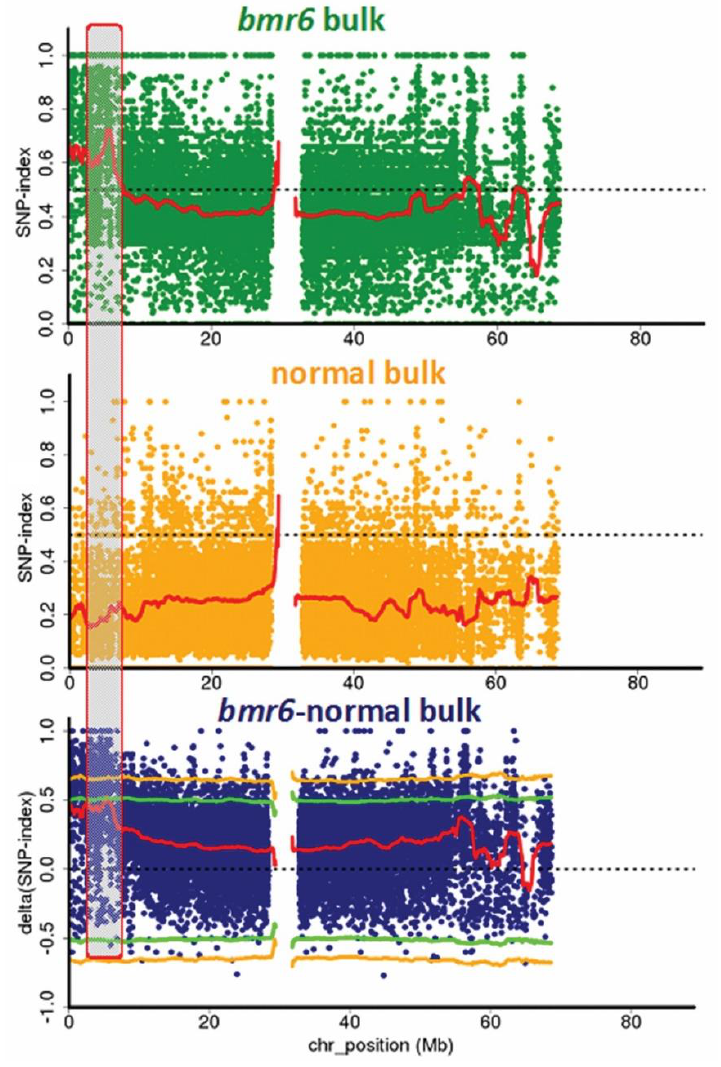
Figure 2. Single nucleotide polymorphism (SNP) analysis to identify bmr6 mutation. SNP index plots of bmr6 bulk ( top ), normal bulk ( middle ) and Δ(SNP-index) plot ( bottom ) of sorghum Chromosome 4 with statistical confidence intervals under the null hypothesis of no QTLs (green, p < 0.05; yellow, p < 0.01). Grey highlighted area shows the QTL near the beginning of Chromosome 4 where the significant difference between the bulks